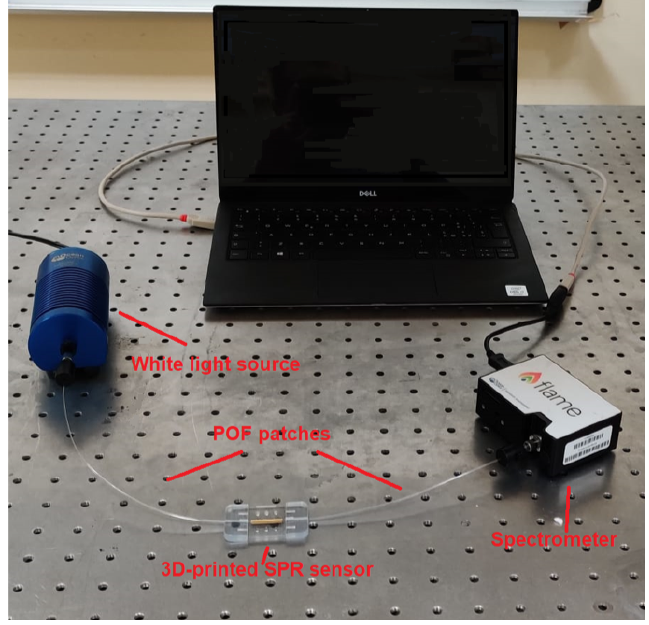
Figure 1. Experimental setup used to test the 3D-printed plasmonic sensor (plastic optical fiber (POF); surface plasmon resonance